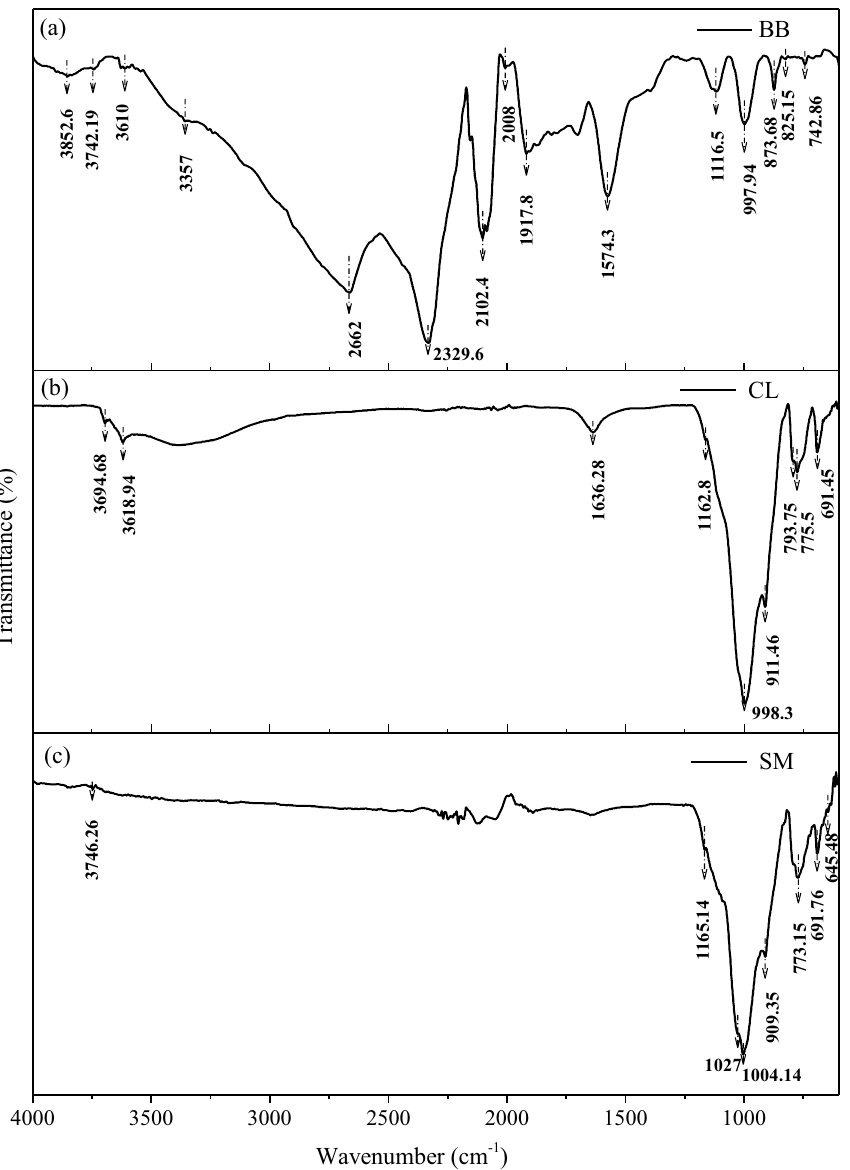
Figure 4. FTIR spectra analysis for powder sample of pure ( a ) bamboo biochar, ( b ) CL and ( c ) SM soil in powder form.